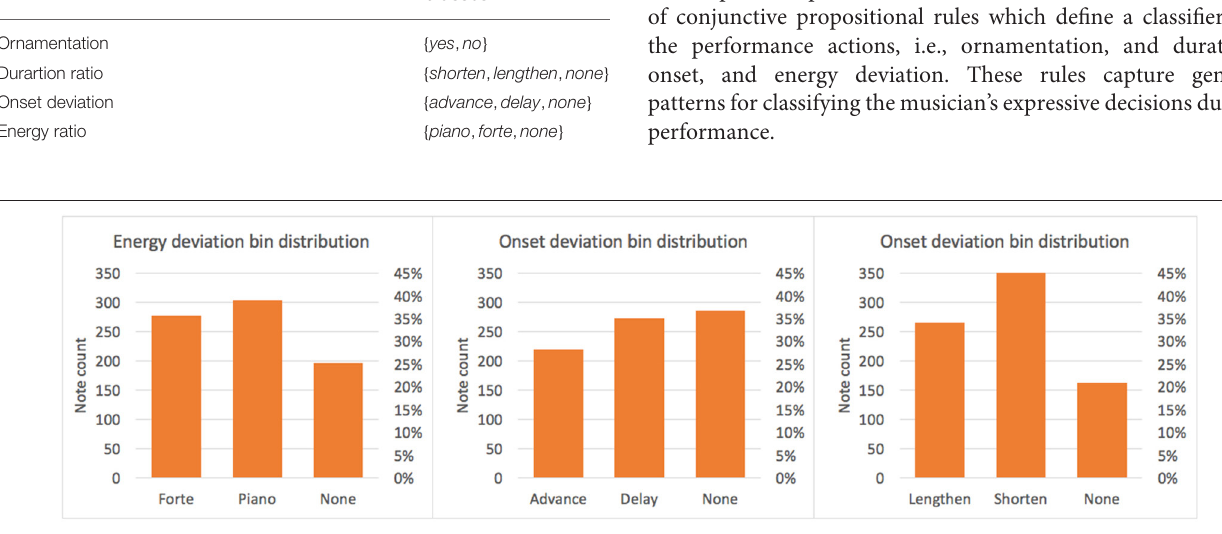
FIGURE 4 | Distribution over quantized bins of performance actions